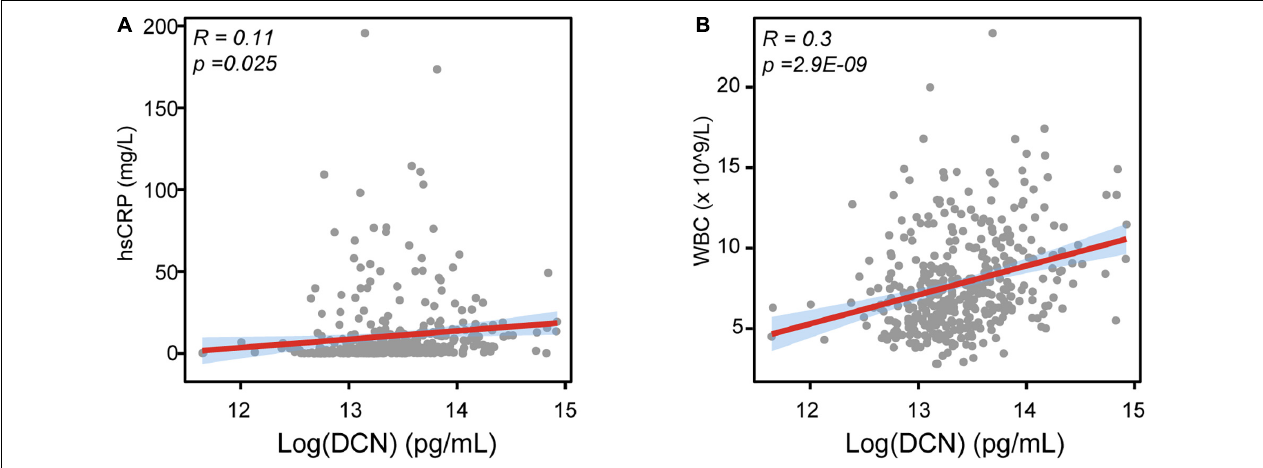
FIGURE 2 | The relationship between DCN with LVEF, WBC, and hsCRP. (A) The correlation between serum DCN with the serum level of hsCRP in enrolled patients. (B) The correlation between serum DCN with the number of white blood cells (WBC) in enrolled patients. R referred to correlation coefficient. TABLE 3 | Univariable and multivariable logistic analysis on the association of DCN and other clinical parameters with ACS. Parameters Univariate Multivariate OR 95% CI p -value OR 95% CI p